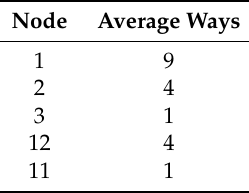
Table 2. Average trips to cover all the siblings on the line of each blue node. Node